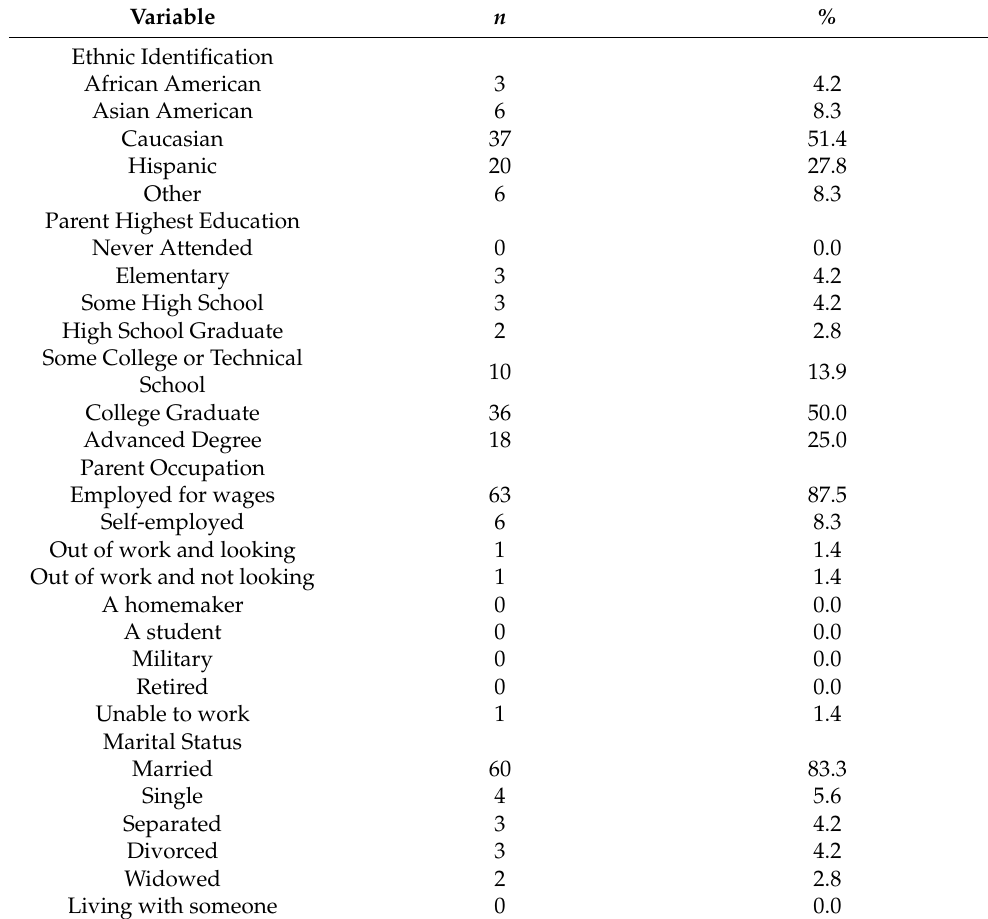
Table 1. A breakdown of school placement based on diagnostic severity level is presented in Table 2. Table 1. Demographic Characteristics of